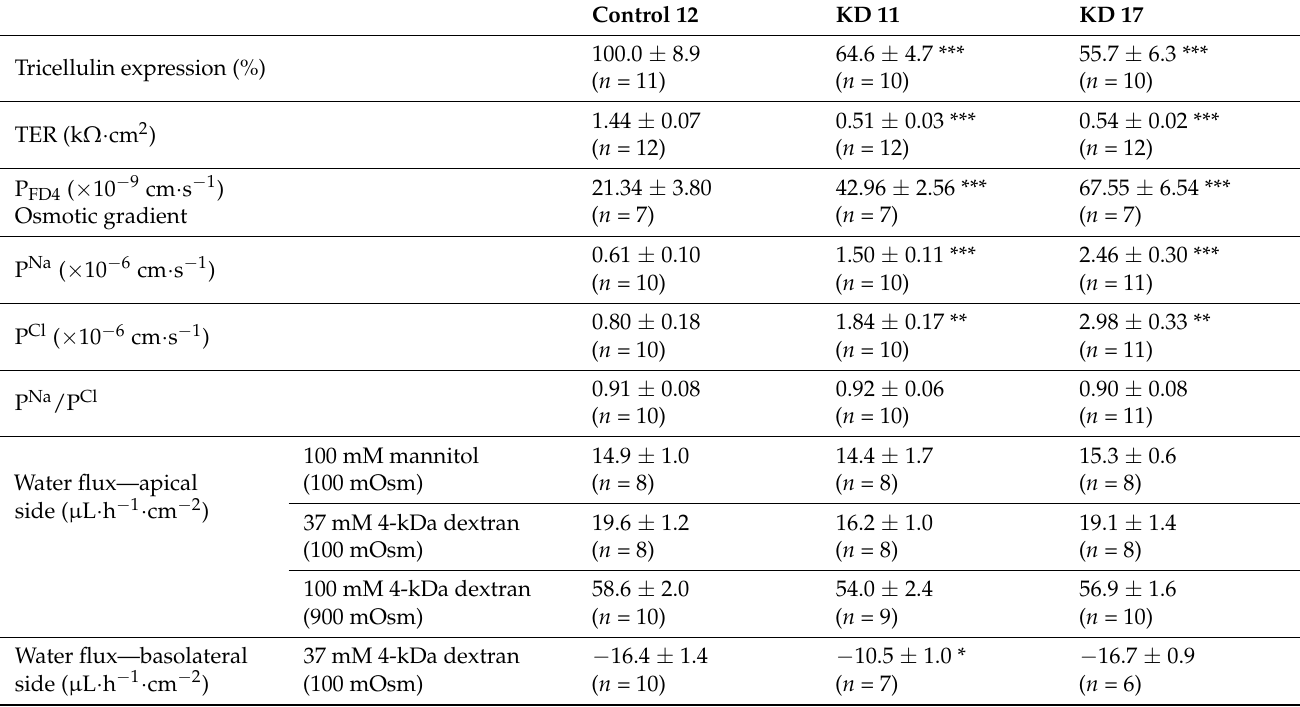
Table 2. Characteristics of HT-29/B6 tricellulin knockdown clones and the corresponding control. Two tricellulin knockdown clones and its corresponding control were analyzed in this study (Control 12, KD 11 and KD 17). Data of tricellulin expression have been obtained by densitometric analysis of Western blots using β -actin for normalization. Paracellular permeability measurements for FD4 were carried out in the Ussing chamber. Data of P Na /P Cl permeability and absolute permeabilities for Na + and Cl − (P Na , P Cl ) were obtained from dilution potential measurements in the Ussing chamber. Water flux measurements were performed in a modified Ussing chamber with water flux induced by different osmotic